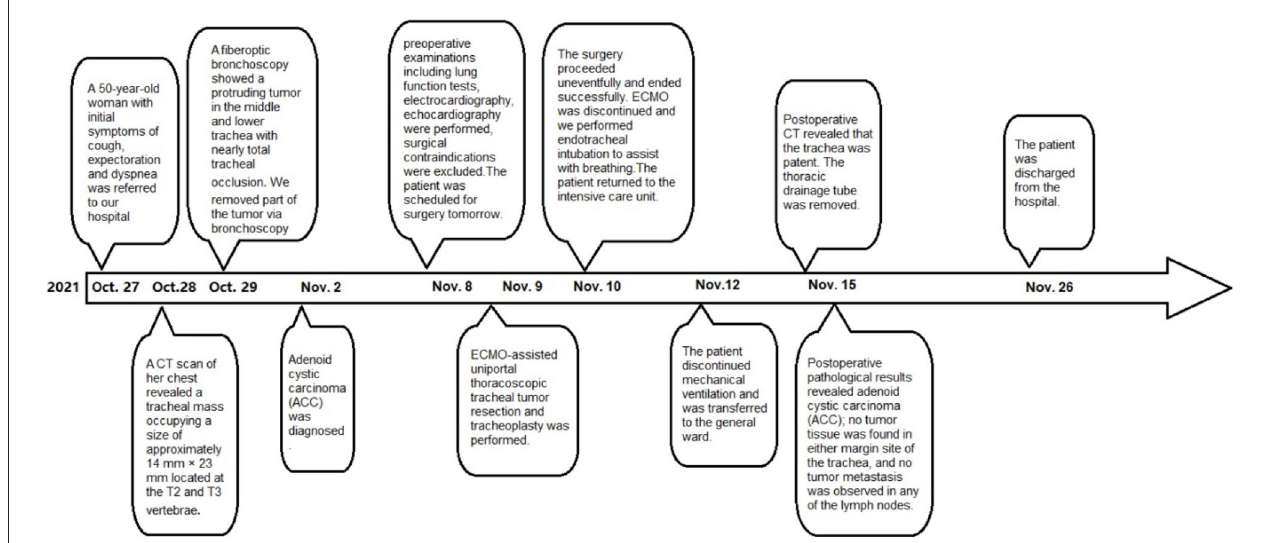
FIGURE 4 | A timeline with relevant data from the episode of